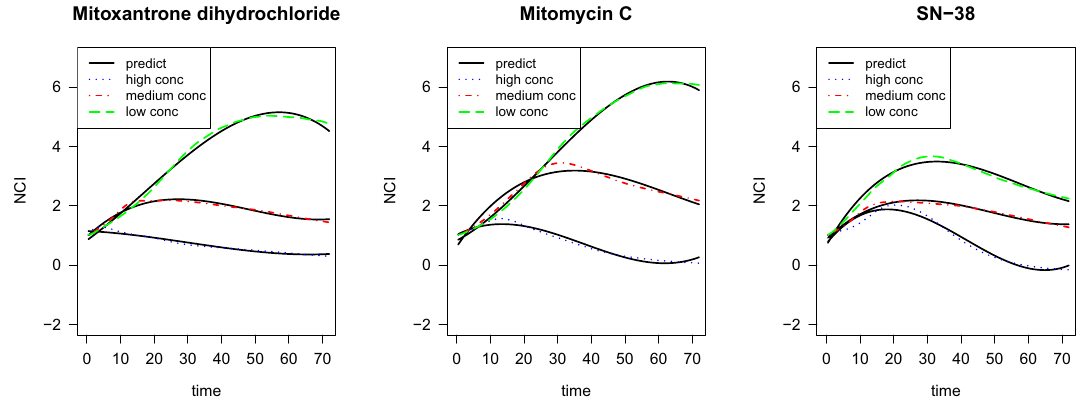
Figure 6. Experimental TCRCs (black plain line) versus predict TCRCs (colored dashed